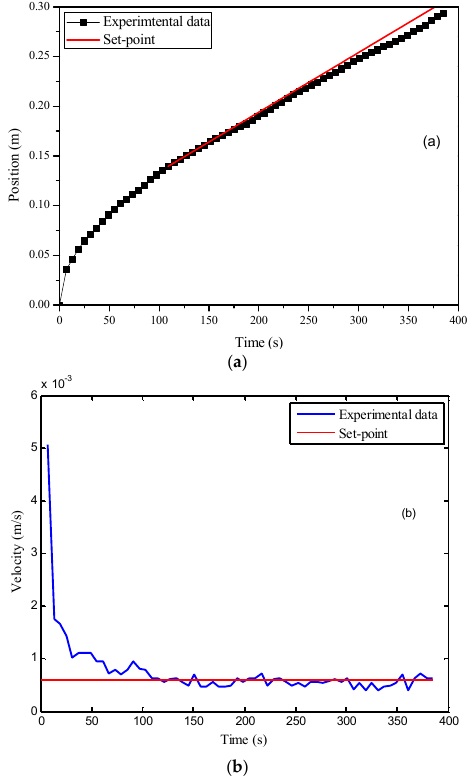
Figure 8. Control results of the MPC (model predictive control) with online permeability estimation: ( a ) time vs. flow front position; ( b ) time vs. flow front velocity.